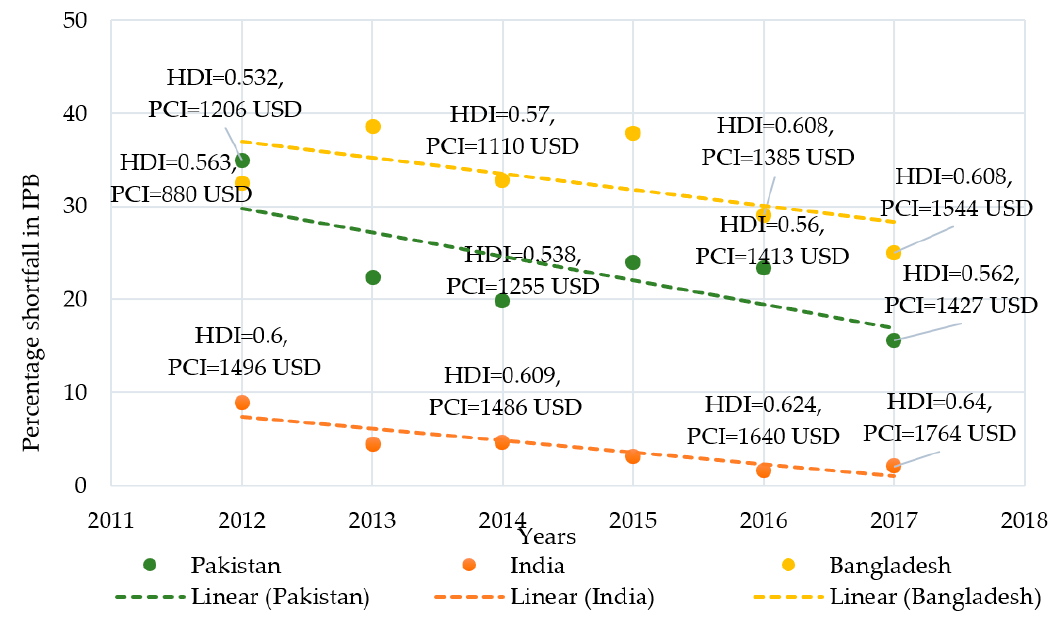
Figure 1. Percentage shortfall, HDI, and PCI in IPB over the years 2012–2017 [8,9].